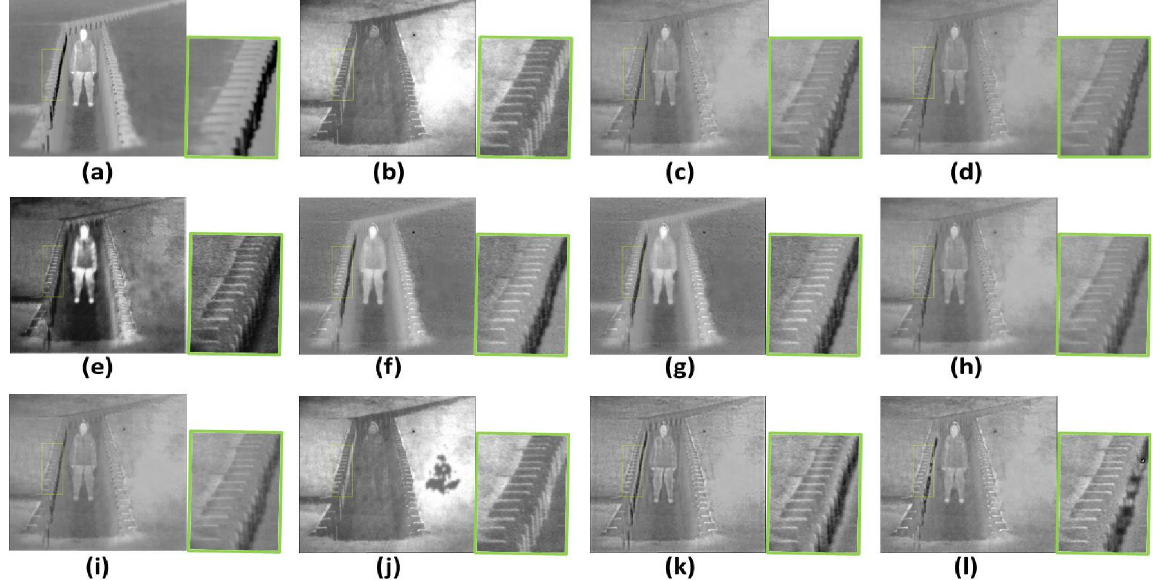
Figure 8. Visual IF results of different methods on soldier in trench: ( a ) IR image, ( b ) VIS image, ( c ) Proposed method, ( d ) [17], ( e ) [22], ( f ) [33], ( g ) [20], ( h ) [34], ( i ) [35], ( j ) [36], ( k ) [37], and ( l )